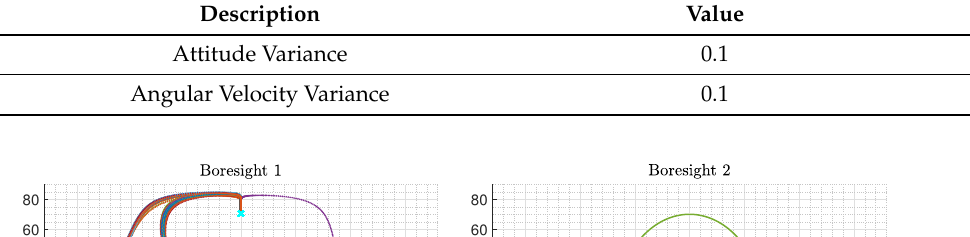
Table 3. Variance Parameters for the Initial Attitude ( σ B / N